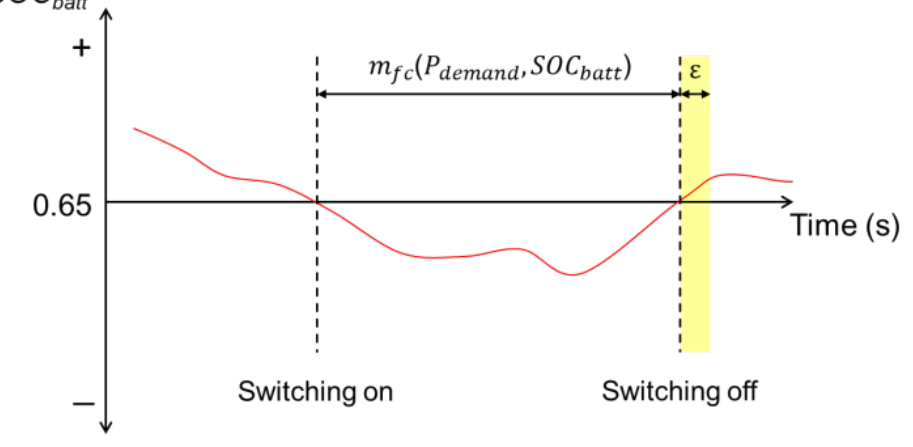
Figure 8. Proposed energy management strategy.